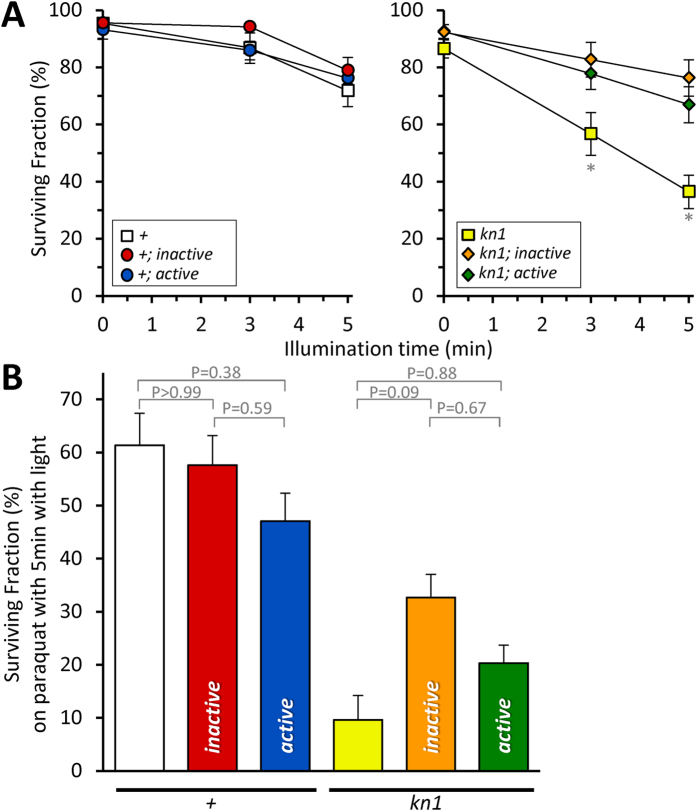
Light-induced phenotypes in a mev-1(kn1)III mutant background.The same strains as shown in Fig. 2 were used to assess: (A) 96-hour survival as a function of light. Staged L1 larvae were illuminated for the indicated amount of time, and survival was scored four days later. *Adjusted P < 0.05 vs all other groups at that light treatment (2-way ANOVA with TUKEY multiple comparisons test). Data from wildtype and kn1 backgrounds are plotted on separate axes for clarity. Data are mean ± SEM. N = 8–18. An “N” is considered an independent trial of 25–100 worms. (B) 96-hour survival as a function of cultivation on plates containing from 200 μM paraquat. Adjusted P values are indicated (one-way ANOVA with Tukey multiple comparisons test). Data are mean ± SEM. N = 8–18. An “N” is considered an independent trial of 25–100 worms. Alleles are abbreviated as outlined in Fig. 1.